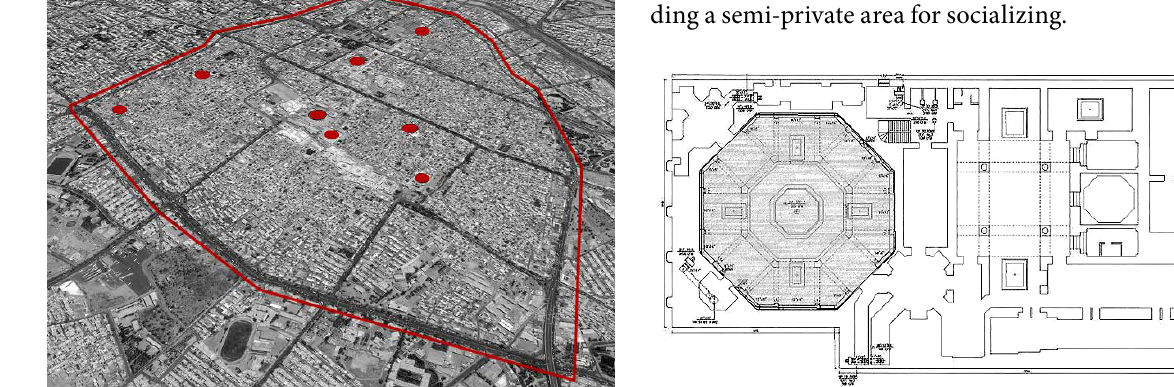
fig. 13. Vakil Bath plan with highlighted hot chamber